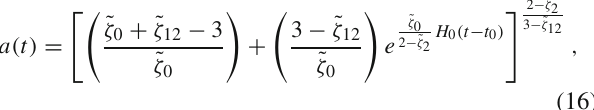
Table 1 Best estimates of the bulk viscous parameters, H 0 and also χ 2